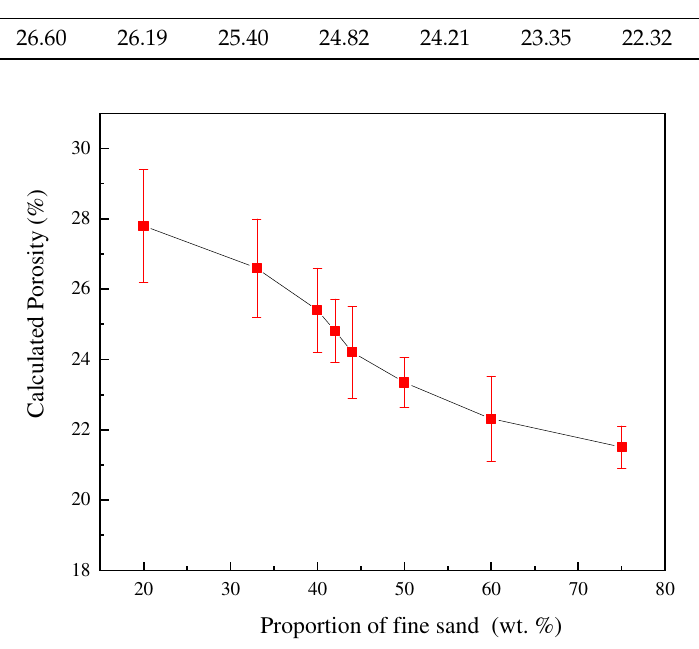
Table 5. Effect of different fine sand proportions on calculated porosity. The proportion of fine sand (wt.%)